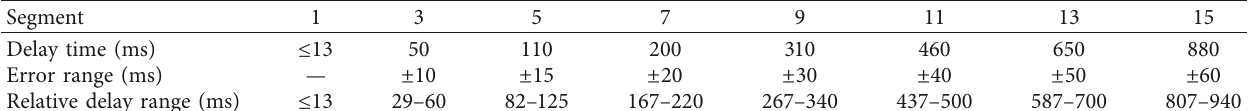
Table 4: Delay time of detonators.